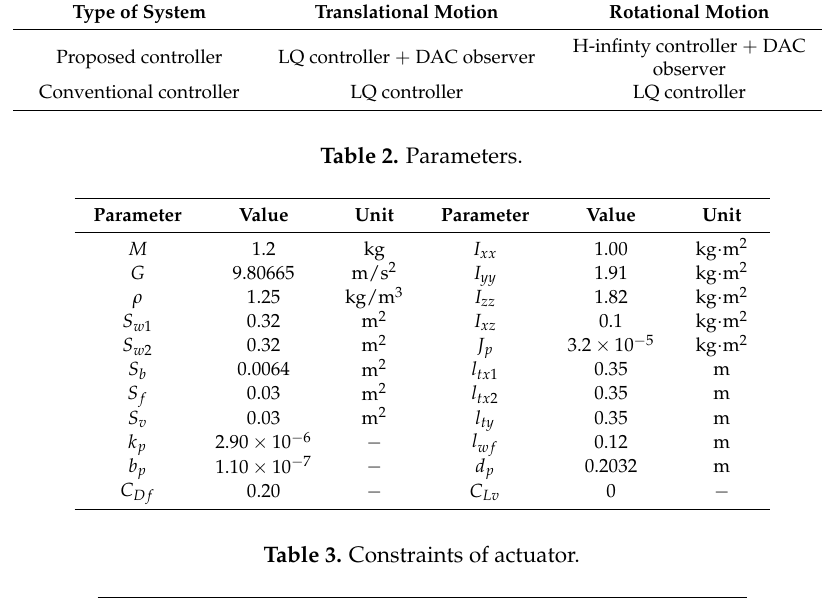
Table 1. System configuration.